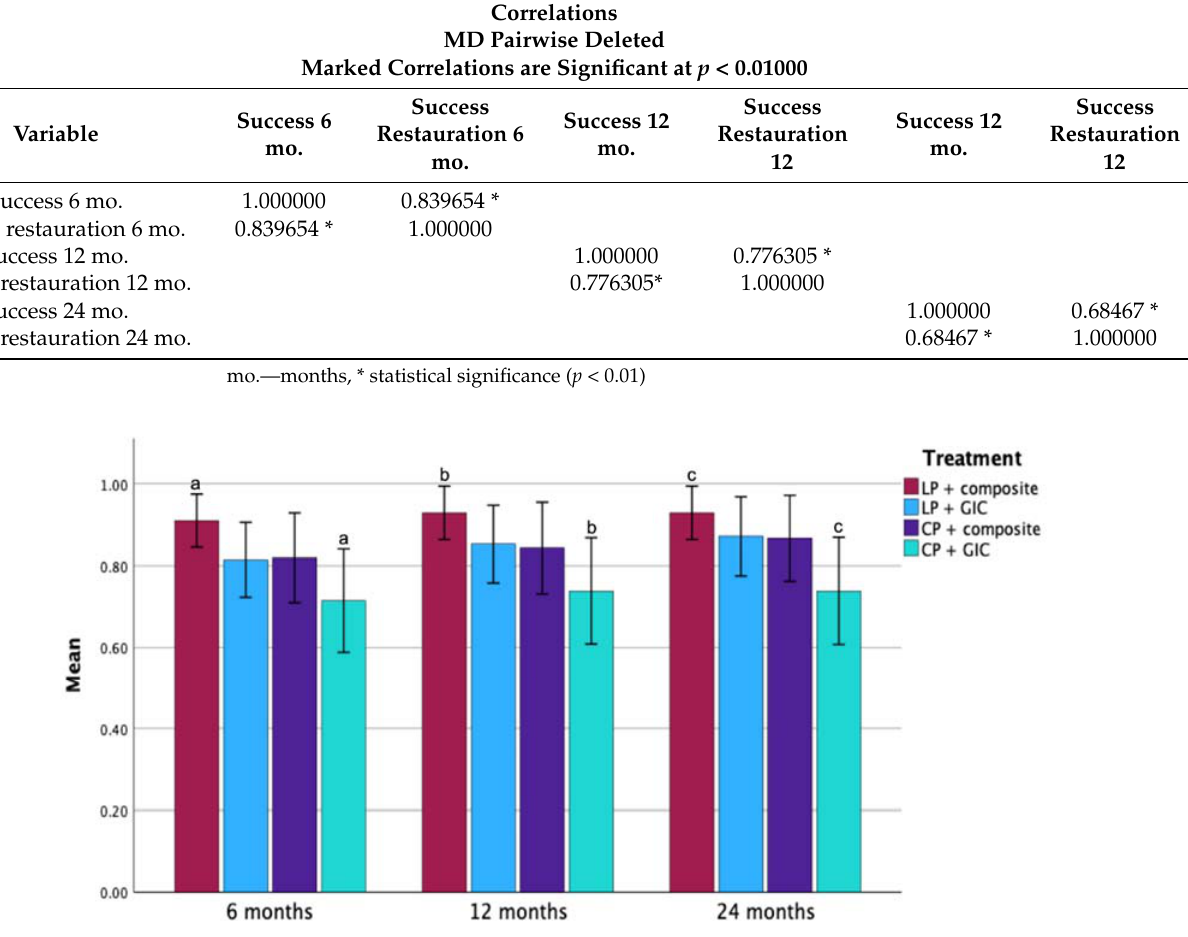
Figure 2. Influence of pulpotomy treatment and final restoration material on clinical success after 6, 12, and 24 months follow-up. LP—laser pulpotomy; CP—conventional pulpotomy; GIC—glass ionomer cement; a, b, and c—statistically significant difference ( p < 0.05).